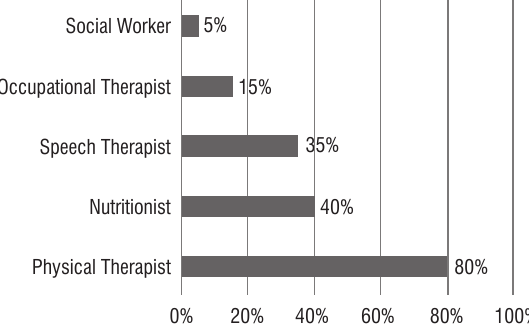
Figure 2 - Percentage of home care provided by each pro- fessional of Family Health-Care Support Centre to stroke patients according to the medical records at primary health- care center.